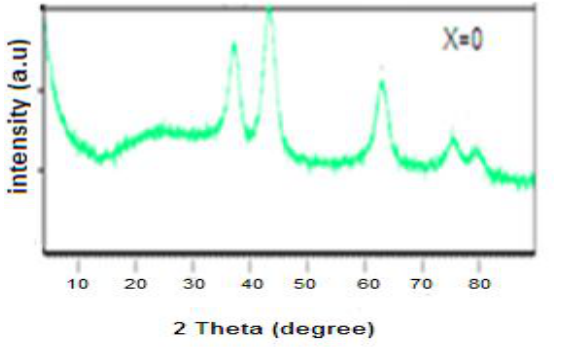
Fig. 1 . XRD pattern of NiO nanoparticles after calcinations.